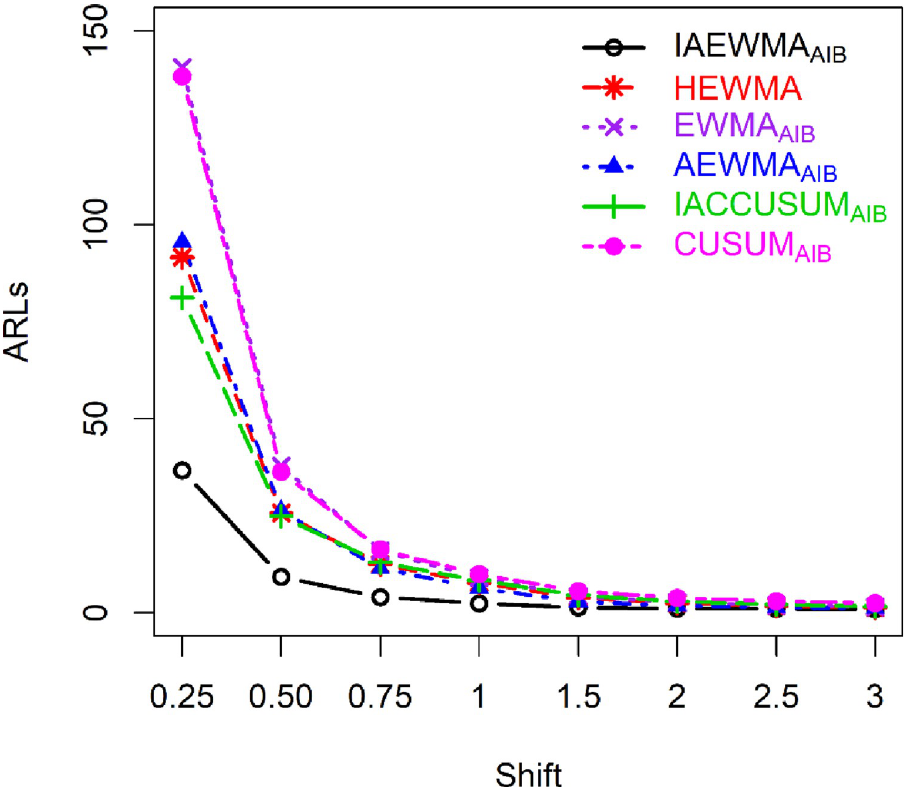
Fig 1. ARL profile of IAEWMA AIB , HEWMA, EWMA AIB , AEWMA AIB , IACCUSUM AIB , and CUSUM AIB control charts at ρ = 0.25, ( λ , λ 2 ) = 0.20, λ 1 = 0.10 when ARL 0 =